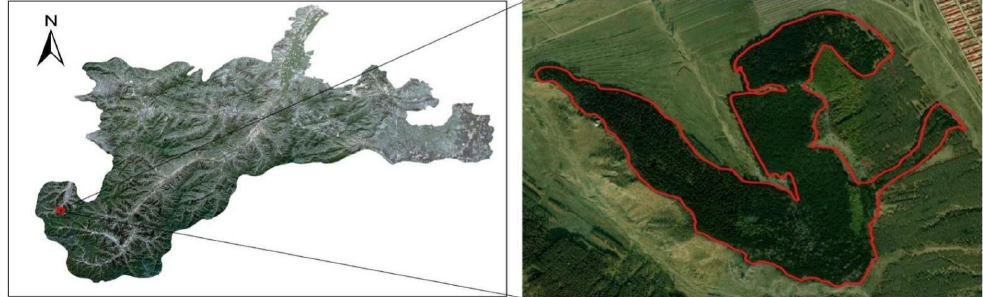
Figure 7. Enlarged view of study area for BF.